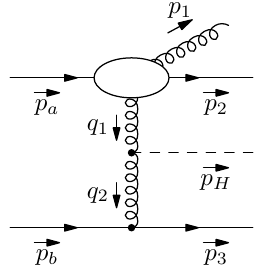
Figure 3 . Rapidity-ordered ladder diagrams for qQ contains just one t -channel gluon propagator, whereas the FKL con(cid:12)guration (right) contains the maximum number, two.